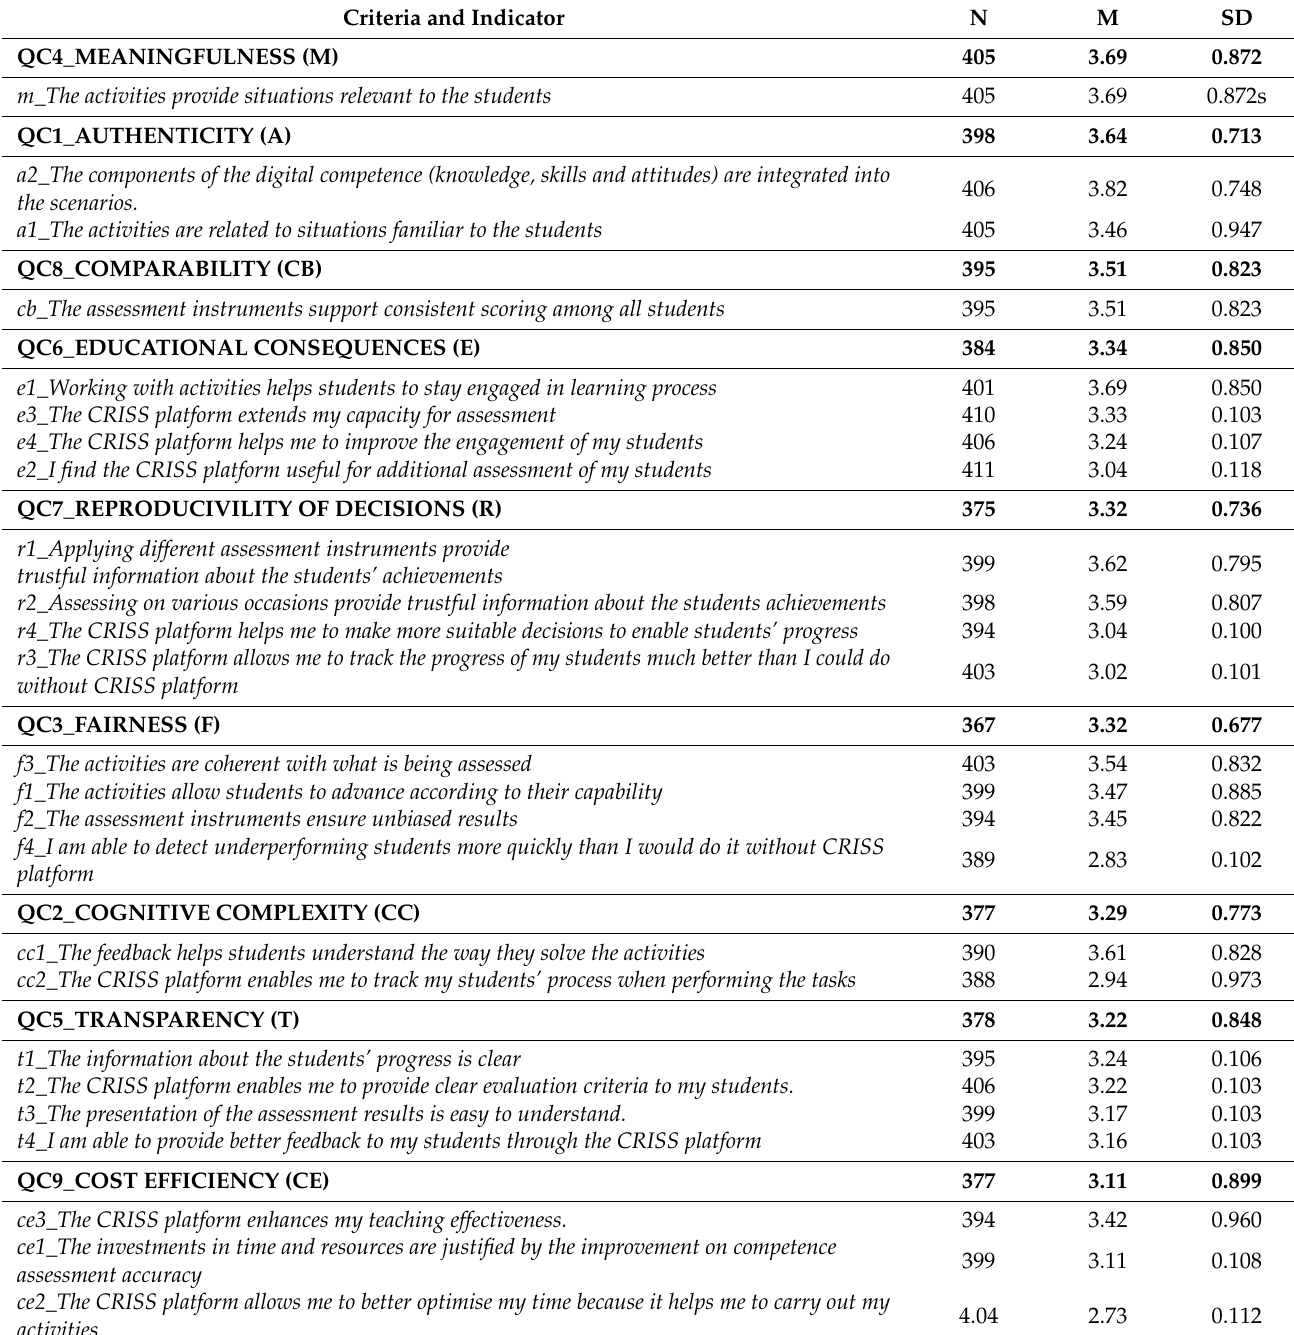
Table 2. QC results of the CAM of digital